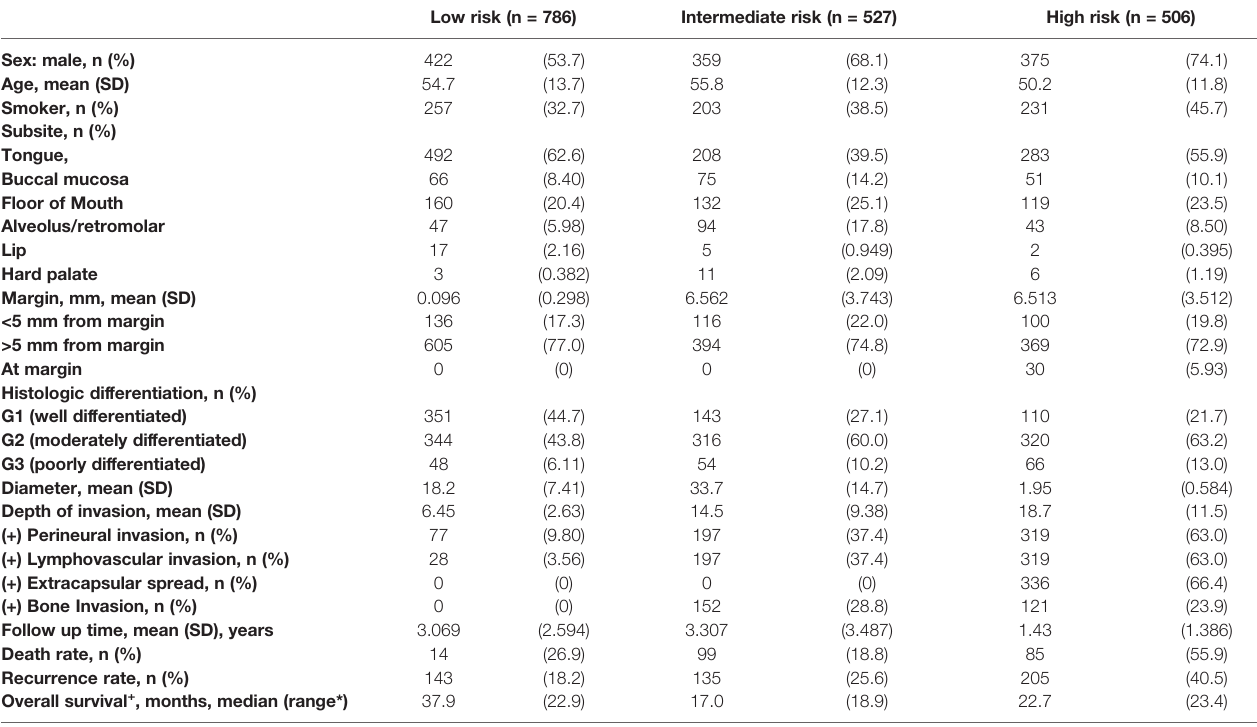
TABLE 1 | Demographic and clinicopathologic pro fi le of patients (n = 1,819).